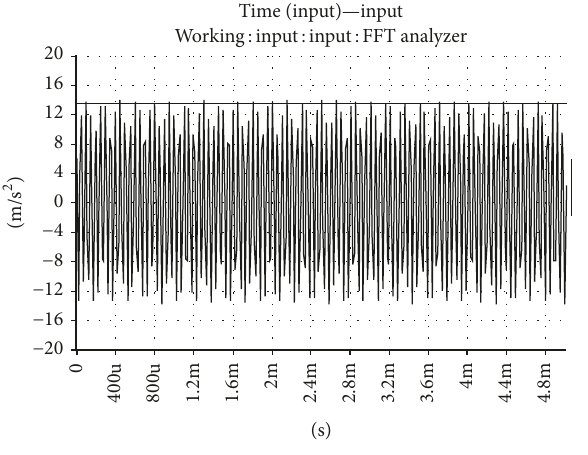
Figure 19: The input signal in frequency domain.